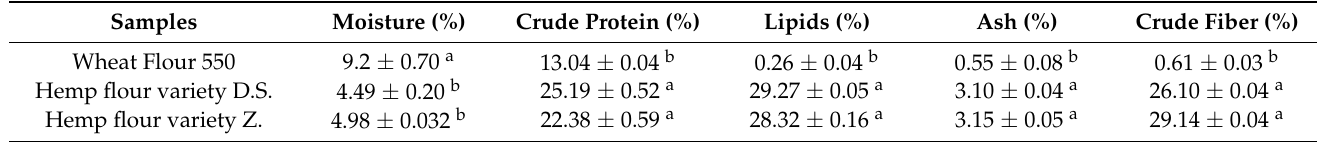
Table 1. Physicochemical properties of wheat flour and hemp flour. Samples Moisture